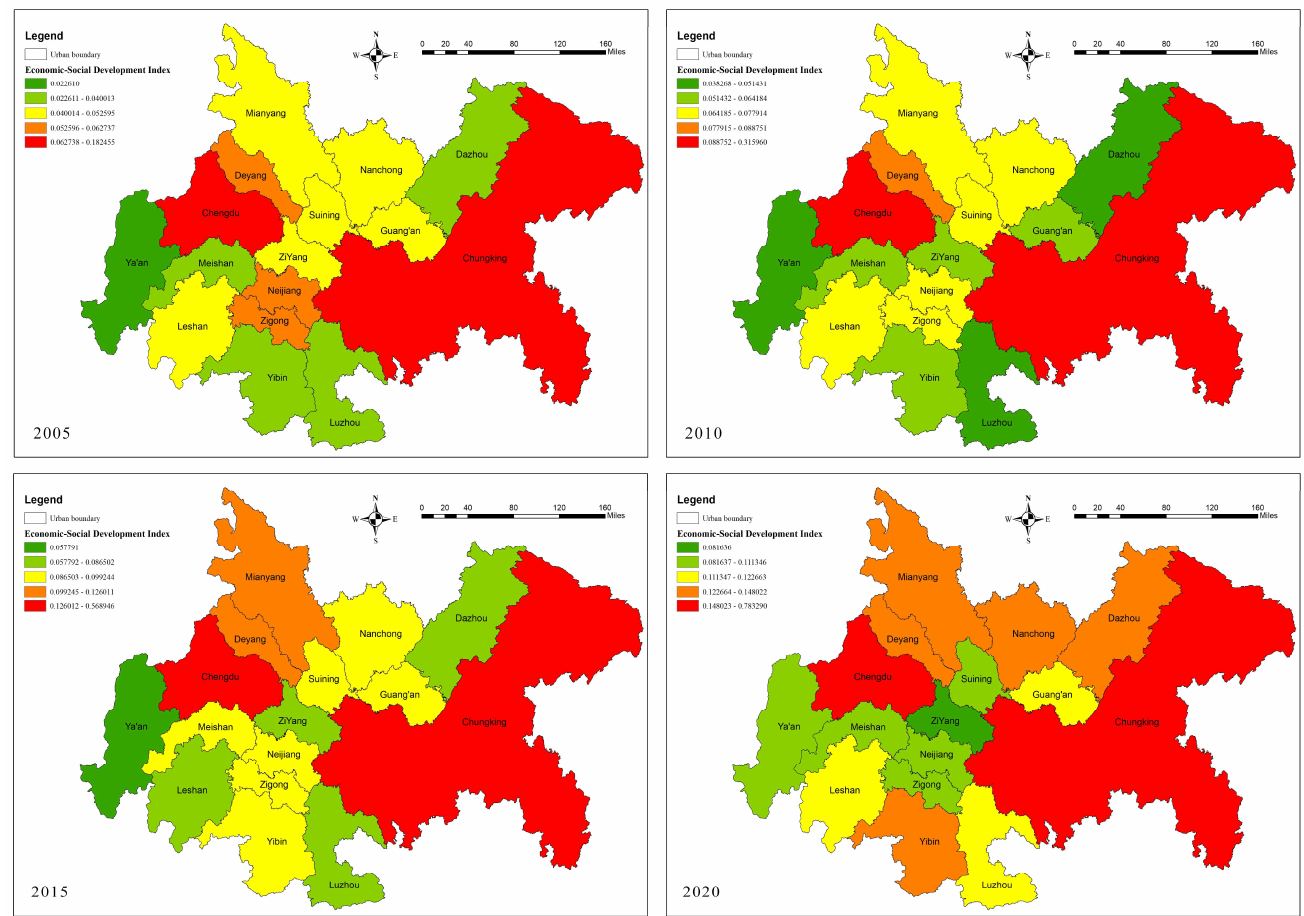
Figure 9. Changes in the economic–social development of cities in CCCG from 2005 to 2020.